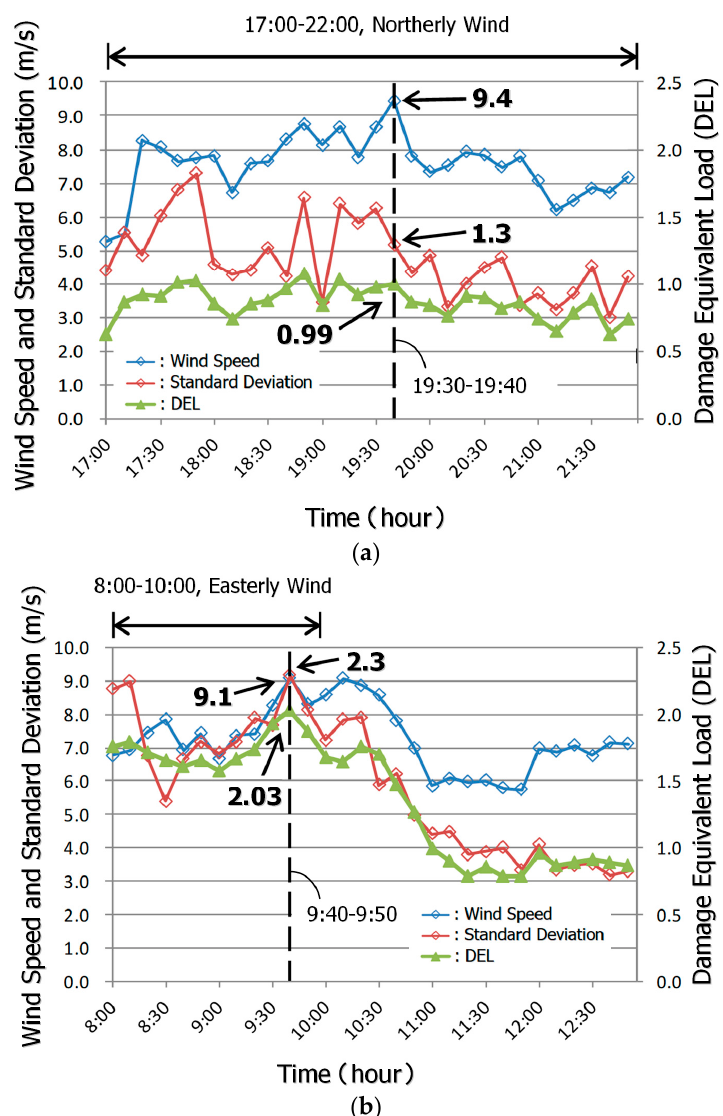
Figure 13. Time series of wind speed, standard deviation and normalized damage equivalent load (DEL) for flapwise blade bending. Plotted values were evaluated from instantaneous data values within 10-minute periods. ( a ) Northerly wind. ( b ) Easterly wind.